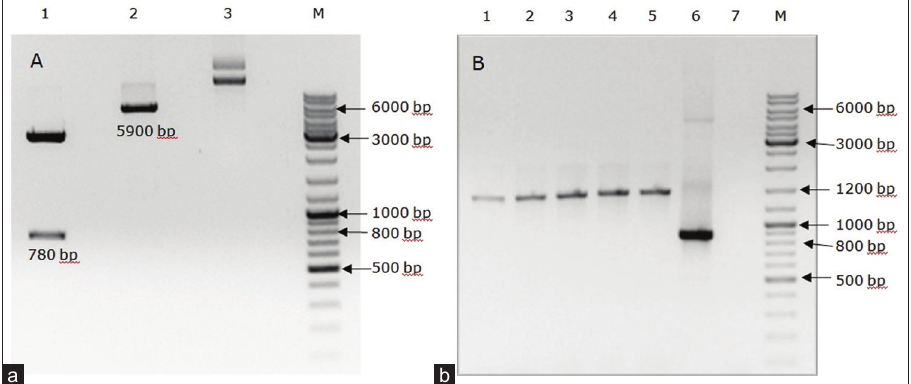
a b Figure-1: Electrophoresis of restriction-digested and polymerase chain reaction (PCR) products on 1% agarose gel. (a) Lane 1: Restriction analysis of pGEM-T/P32, Lane 2: pET32а plasmid digested with enzymes, Lane 3: pET32а plasmid without enzyme treatment; Lane M: DNA ladder (#SM0333, Thermo Fisher Scientific). (b) Сolony PCR. Lanes 1–5: Positive clones, Lane 6: Positive control, Lane 7: Negative control, Lane M: DNA ladder (#SM0333, Thermo Fisher Scientific).